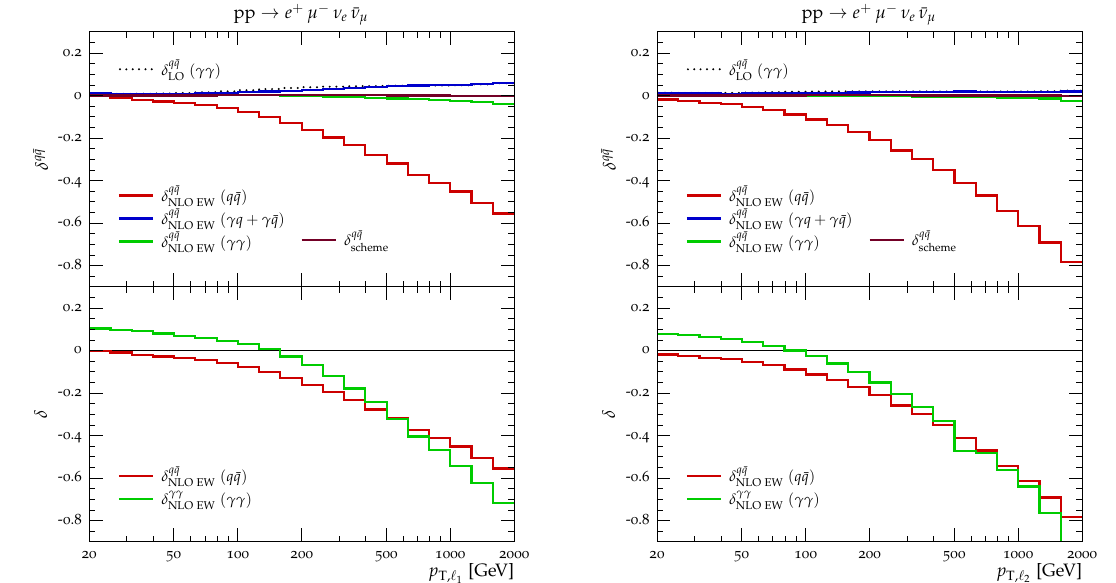
Figure 23 . Relative corrections in the transverse momentum of the leading and subleading lepton, p T ;‘ and p T ;‘ , for pp e + (cid:22) (cid:0) (cid:23) e (cid:22) (cid:23) (cid:22) at 13 TeV. In the upper panel we show the relative corrections 1 2 ! to the LO q (cid:22) q channel, induced by the LO (cid:13)(cid:13) channel ( (cid:14) q (cid:22) q ( (cid:13)(cid:13) )), and the NLO EW q (cid:22) q -, q(cid:13) /(cid:22) q(cid:13) - and LO (cid:13)(cid:13) -induced processes ( (cid:14) q (cid:22) q ( q (cid:22) q ), (cid:14) q (cid:22) q ( q(cid:13) + (cid:22) q(cid:13) ), (cid:14) q (cid:22) q ( (cid:13)(cid:13) ), respectively). We further NLO EW NLO EW NLO EW also show the relative size of the scheme conversion term of (4.13) with respect to the LO q (cid:22) q channel ( (cid:14) q (cid:22) q ). The lower panel shows the q (cid:22) q - and (cid:13)(cid:13) -induced NLO EW corrections relative to the LO scheme cross section in the q (cid:22) q and (cid:13)(cid:13) channel, respectively. At large transverse momenta, this corresponds to the channels’ respective electroweak Sudakov corrections.